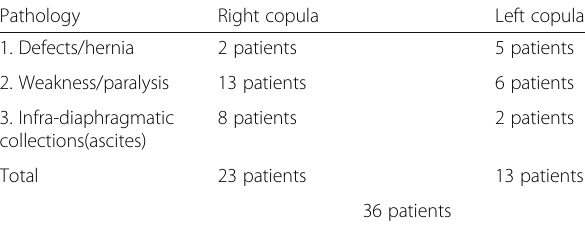
Table 1 Demonstrating the type of pathology for each hemidiaphragm and the number of affected patients Pathology Right copula Left copula